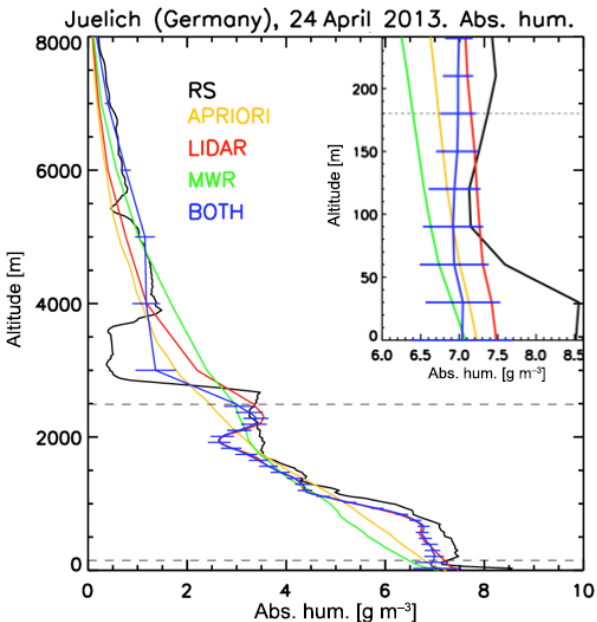
Figure 2. Absolute humidity profiles for a priori (yellow), only- RL (red), only-MWR (green) and MWR+RL (blue). The horizon- tal blue lines correspond to the theoretical retrieval error for the MWR+RL case. The RS is used as reference (black). The dashed horizontal gray lines enclose the region where the lidar data are used. The inset is a zoom for the region close to the ground, be- tween 0 and 250m.